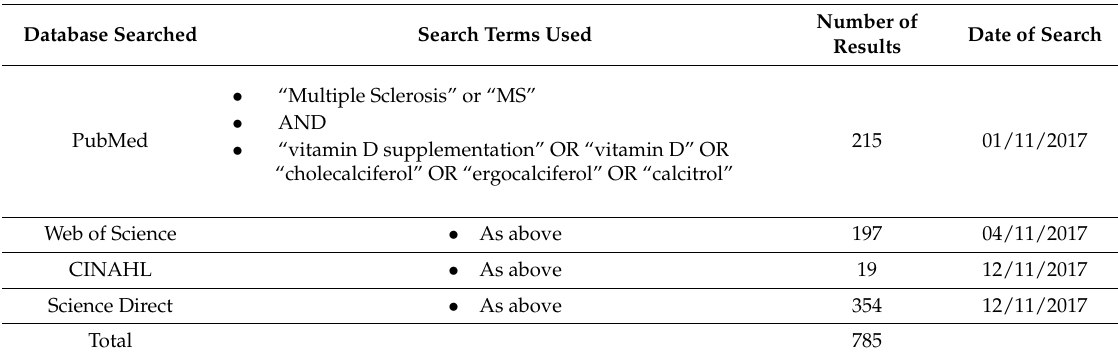
Table 1. Key search databases and search